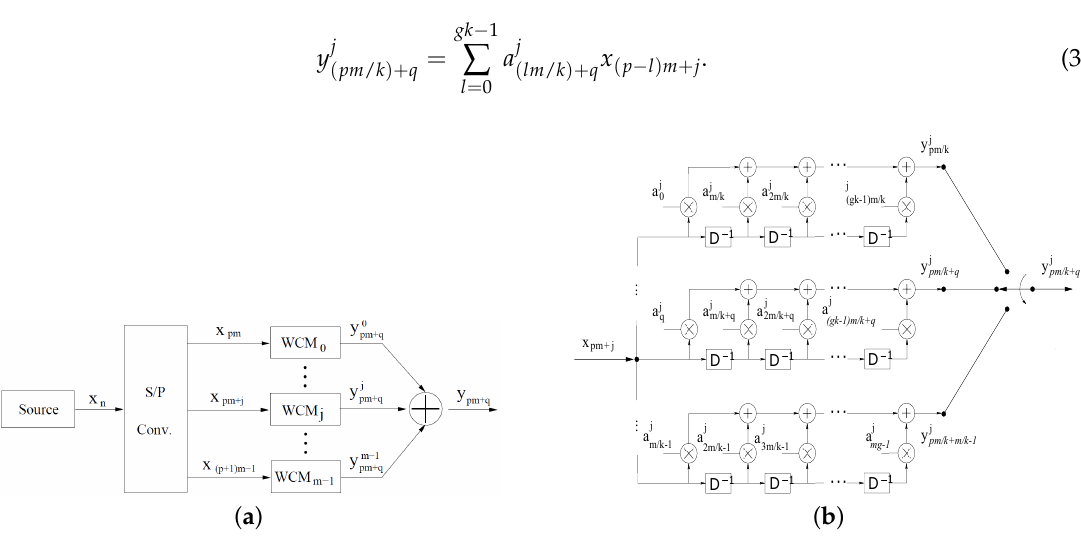
Figure 1. Encoder overview ( a ) and detailed view of MCW j blocks of the wavelet encoder ( b